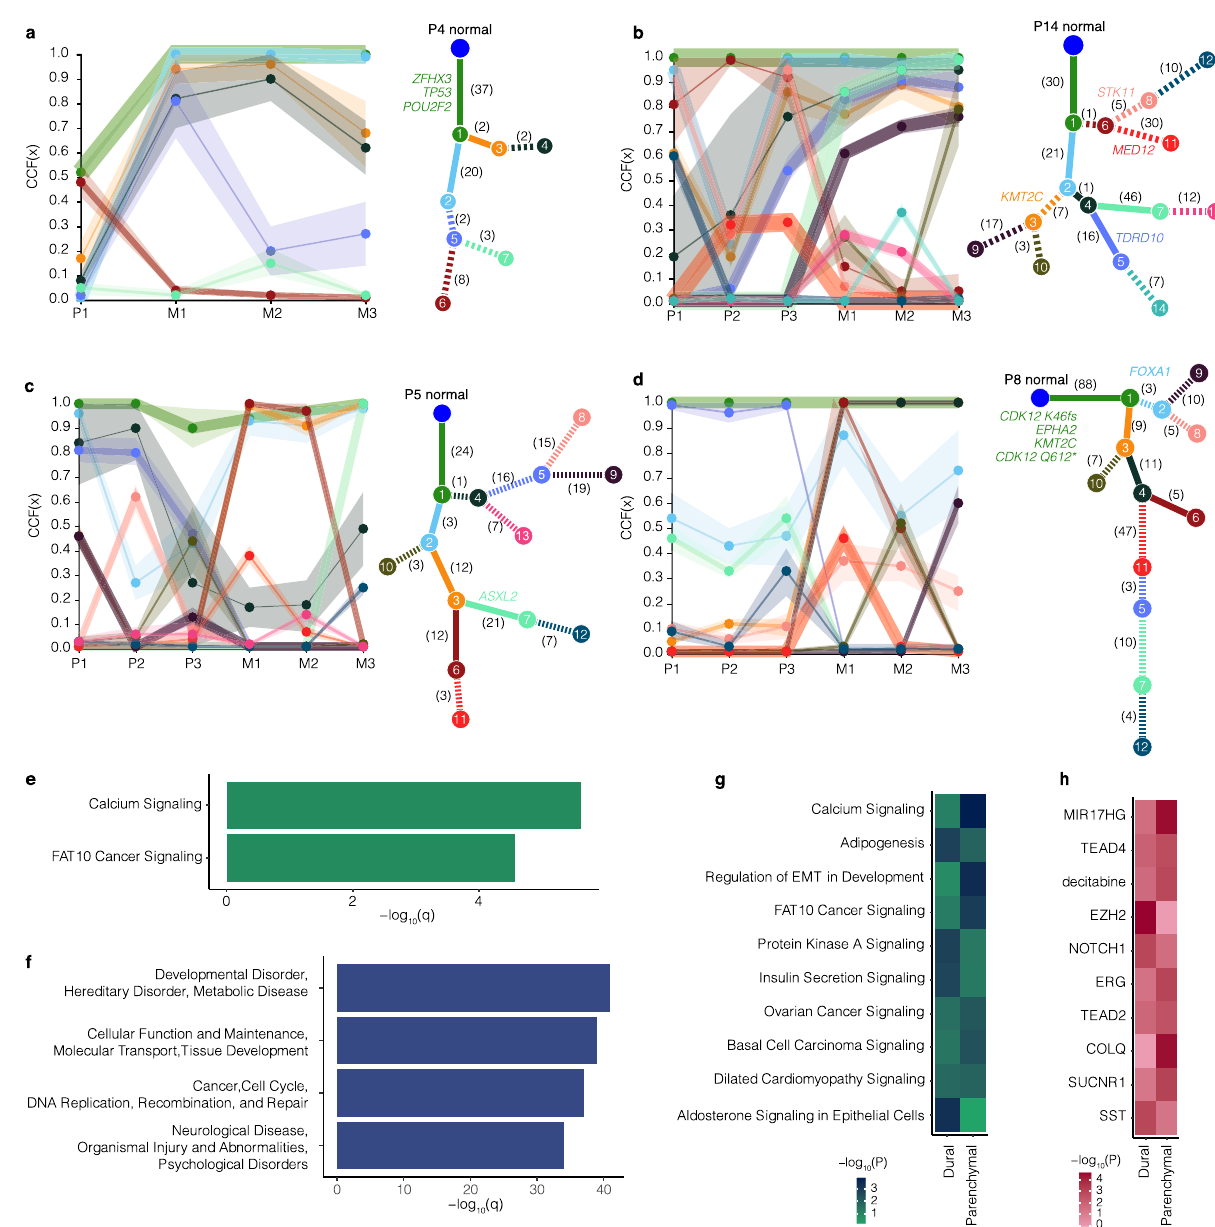
Fig. 3 Clonal evolution in PCBM Clonal evolution in four patients from the PCBM cohort. Patients P4 ( a ) and P14 ( b ) had dural metastases, and patients P5 ( c ) and P8 ( d ) had parenchymal metastases. Trace plots show cancer cell fraction (CCF) for each mutational cluster in each patient sample (P = primary, M = metastasis). Ribbons show 95% con fi dence interval, center of bands show mean cluster CCF estimate. Phylogenetic trees show best solution for evolutionary relationship between clones with different clusters of mutations where each node (numbered) is a cluster of mutations. Numbers on each branch show the number of mutations distinguishing a clone from the previous (all genes). Potential driver genes mutated in the distinction between a clone and the previous are indicated in colors corresponding to the branch. Solid branches show clusters of mutations which become clonal in metastatic samples. e Enrichment for canonical pathways associated with genes in mutational clusters, that expand from subclonal in primary samples to clonal in at least one metastatic sample from all 20 patients with primary and metastatic samples calculated using Ingenuity Pathway Analysis. f As for e but showing enrichment for gene networks associated with metastatic-clonal genes. g As for e but with metastatic-clonal genes in dural and parenchymal metastases analyzed separately. h As for g but examining gene sets de fi ned by their upstream regulator. Enrichment was calculated using two-sided Fisher ’ s exact test. Plotted P -values are unadjusted. Source data are provided as a Source Data fi